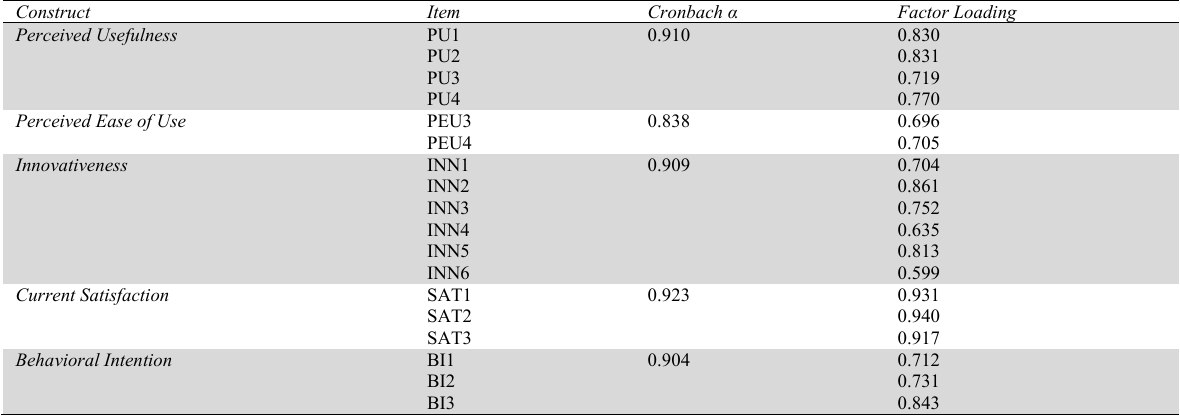
Fig. 2. Personal characteristics of the participants Instrument Reliability and